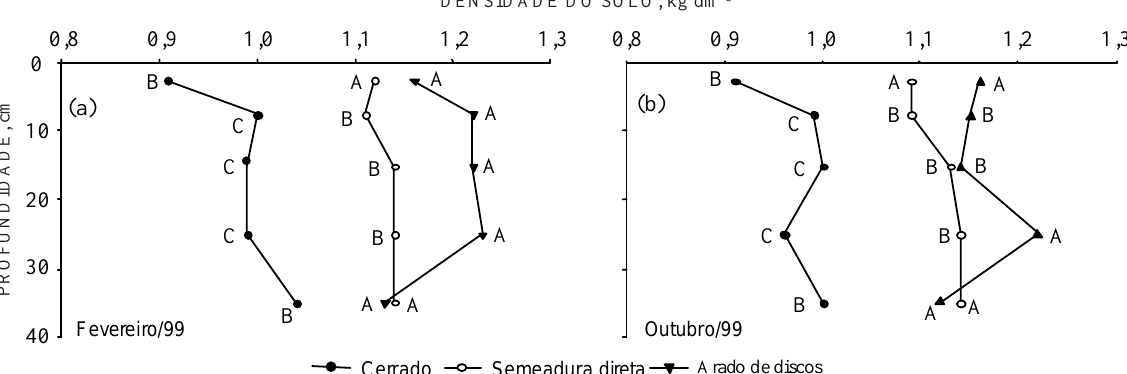
Figura 1. Densidade do solo em cinco profundidades e duas épocas de coleta (fevereiro/99 e outubro/99), do Latossolo Vermelho, sob manejos diferenciados. Dentro de cada profundidade, independentemente de época, as médias que apresentam a mesma letra não apresentam diferenças estatísticas entre si pelo teste de Scott-Knott (p <